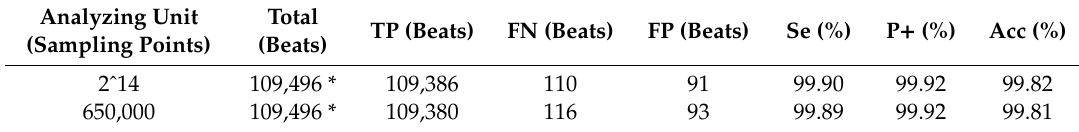
Table 3. R-peak detection performance comparison by di ff erent analyzing units.